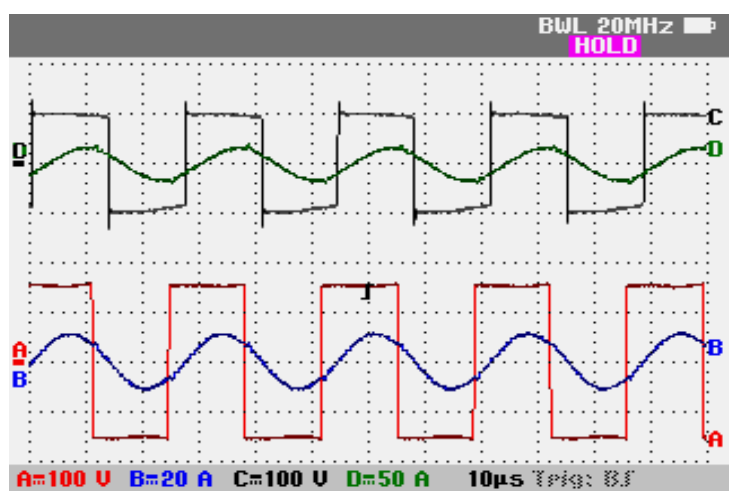
Figure 22. Oscilloscope screenshot for waveforms of the primary resonant voltage (A, magenta, 100 V/div), current (B, blue, 10 mV/A), secondary resonant voltage (C, black, 100 V/div), and current (D, green, 10mV/A) measurements for 1 kW output power and 150 V DC input.